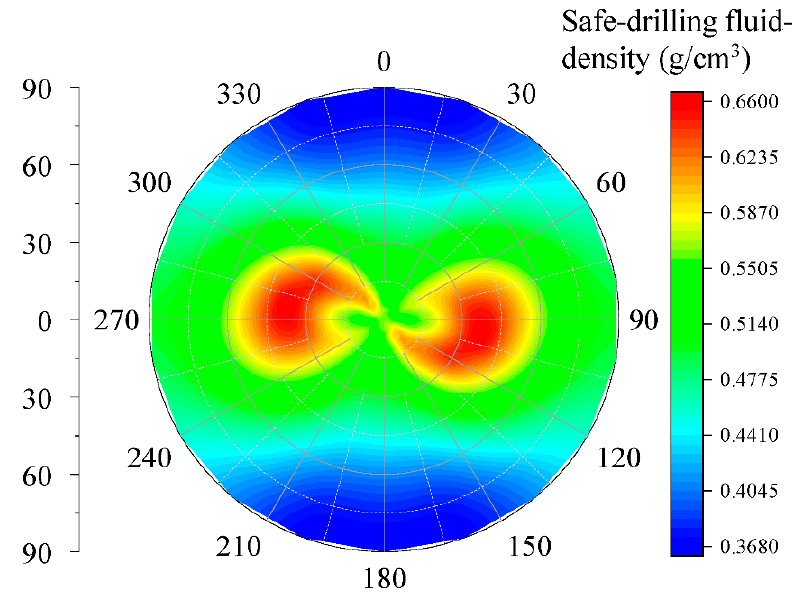
Figure 11. Window distribution cloud diagram for safe drilling fluid density.